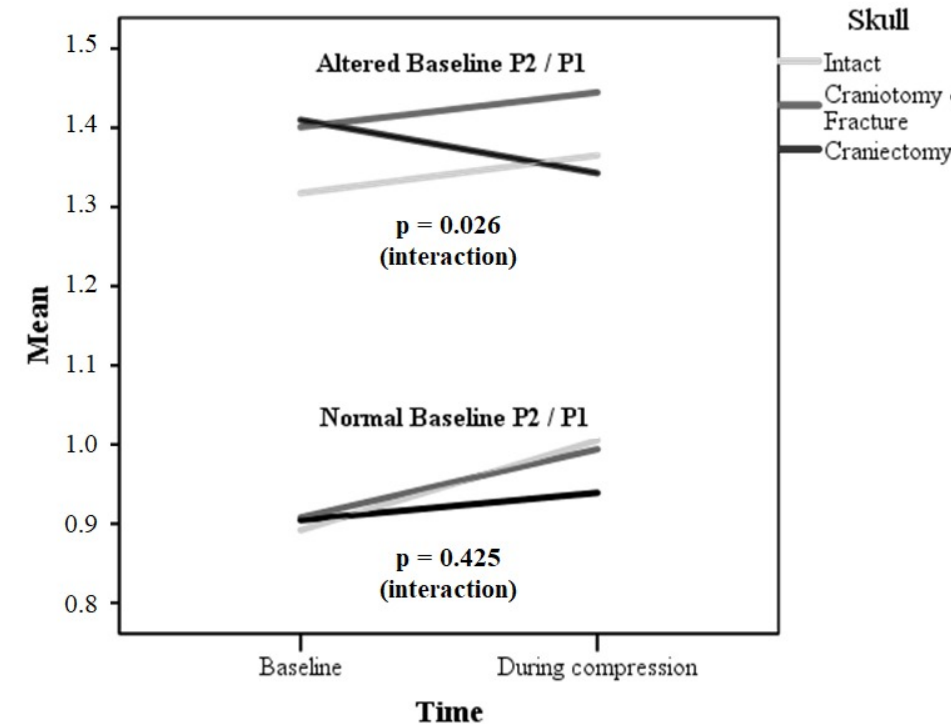
Figure 6. P2/P1 according to skull defect and baseline P2/P1 status.